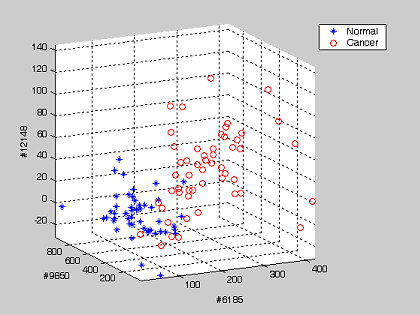
Prostate dataset: an example showing the projection of 102 tissue samples on the top three discriminating axes of the single gene expression patterns. The gene numbers are shown as the axis labels. The threshold values Ti for normal tissues on each axis are tabulated on Table 7.